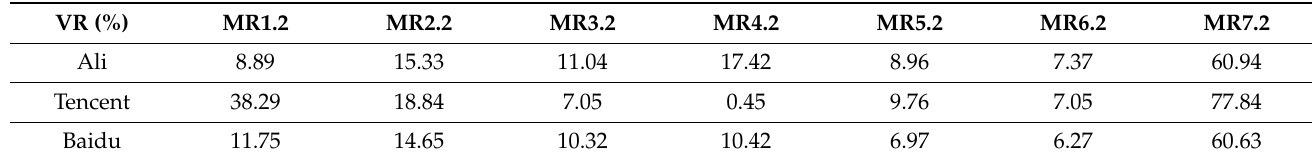
Table 8. Results of text summarization.